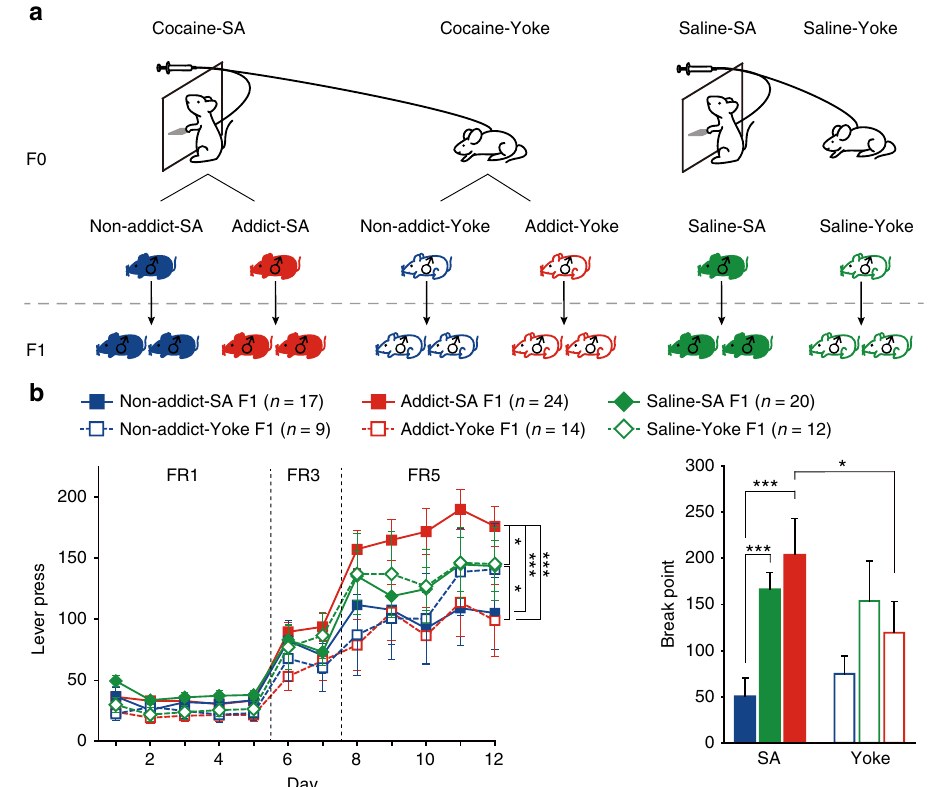
Figure 5 | The inheritance of vulnerability to cocaine reinforcement is contingent on highly motivated cocaine self-administration. ( a ) Naive male rats were randomly paired. In each pair, one rat was allowed to actively self-administer cocaine or saline by pressing the lever (SA group), and with each drug infusion by SA group rat, a yoked infusion of exactly the same dose of cocaine or saline (Saline-Yoke) was delivered at the same time passively (without lever press) to the paired rat (Yoke group). The yoked rats corresponding to Saline-SA, Addict-SA and Non-addict-SA groups were designated as Saline- Yoke, Addict-Yoke and Non-addict-Yoke, respectively. ( b ) Addict-SA F1 rats showed significantly higher lever press and break point for cocaine than Non- addict-SA F1, but there was no difference between Addict-Yoke F1 and Non-addict-Yoke F1. Lever press, Group (cid:3) Yoke (cid:3) FR, MMRM, w 2 (4) ¼ 35.55, P o 0.001; P o 0.001, Saline F1 versus Non-addict F1, P o 0.001, Non-addict F1 versus Addict F1; FR5, *** P o 0.001, Addict-SA F1 versus Non-addict-SA F1, * P ¼ 0.013, Addict-SA F1 versus Saline-SA F1, *** P o 0.001, Addict-SA F1 versus Addict-Yoke F1; * P ¼ 0.038, Addict-Yoke F1 versus Saline-Yoke F1. Break point, two-way ANOVA by Ranks, F Group (cid:3) Yoke (2, 91) ¼ 3.604, P ¼ 0.090; *** P o 0.001, Addict-SA F1 versus Non-addict-SA F1, *** P o 0.001, Non-addict-SA F1 versus Saline-SA F1, * P ¼ 0.041, Addict-SA F1 versus Addict-Yoke F1. Non-addict-SA F1, n ¼ 17; Non-addict-Yoke F1, n ¼ 9; Addict-SA F1, n ¼ 24; Addict- Yoke F1, n ¼ 14; Saline-SA F1, n ¼ 20; Saline-Yoke F1, n ¼ 12. Data are expressed as mean ±